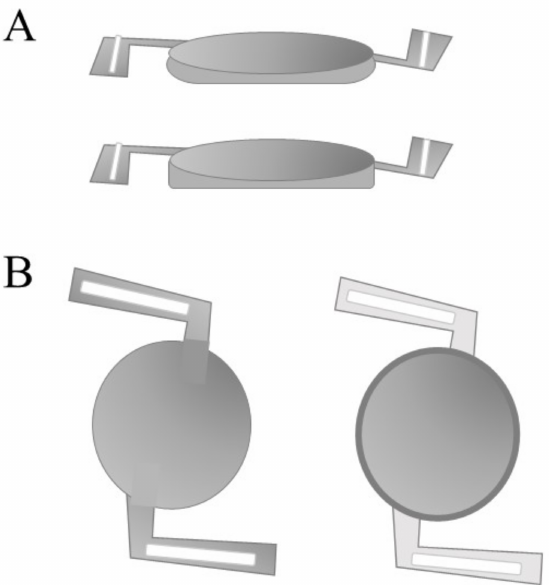
Figure 2. ( A ) Schematic design of an intraocular lens with a rounded optic edge (top) and squared optic (bottom). ( B ) Schematic design of the single-piece IOL (left) and three-piece IOL (right)